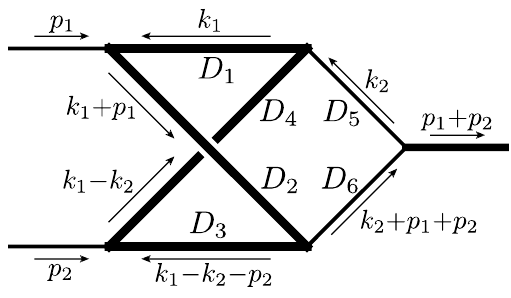
Figure 5 . The elliptic nonplanar double